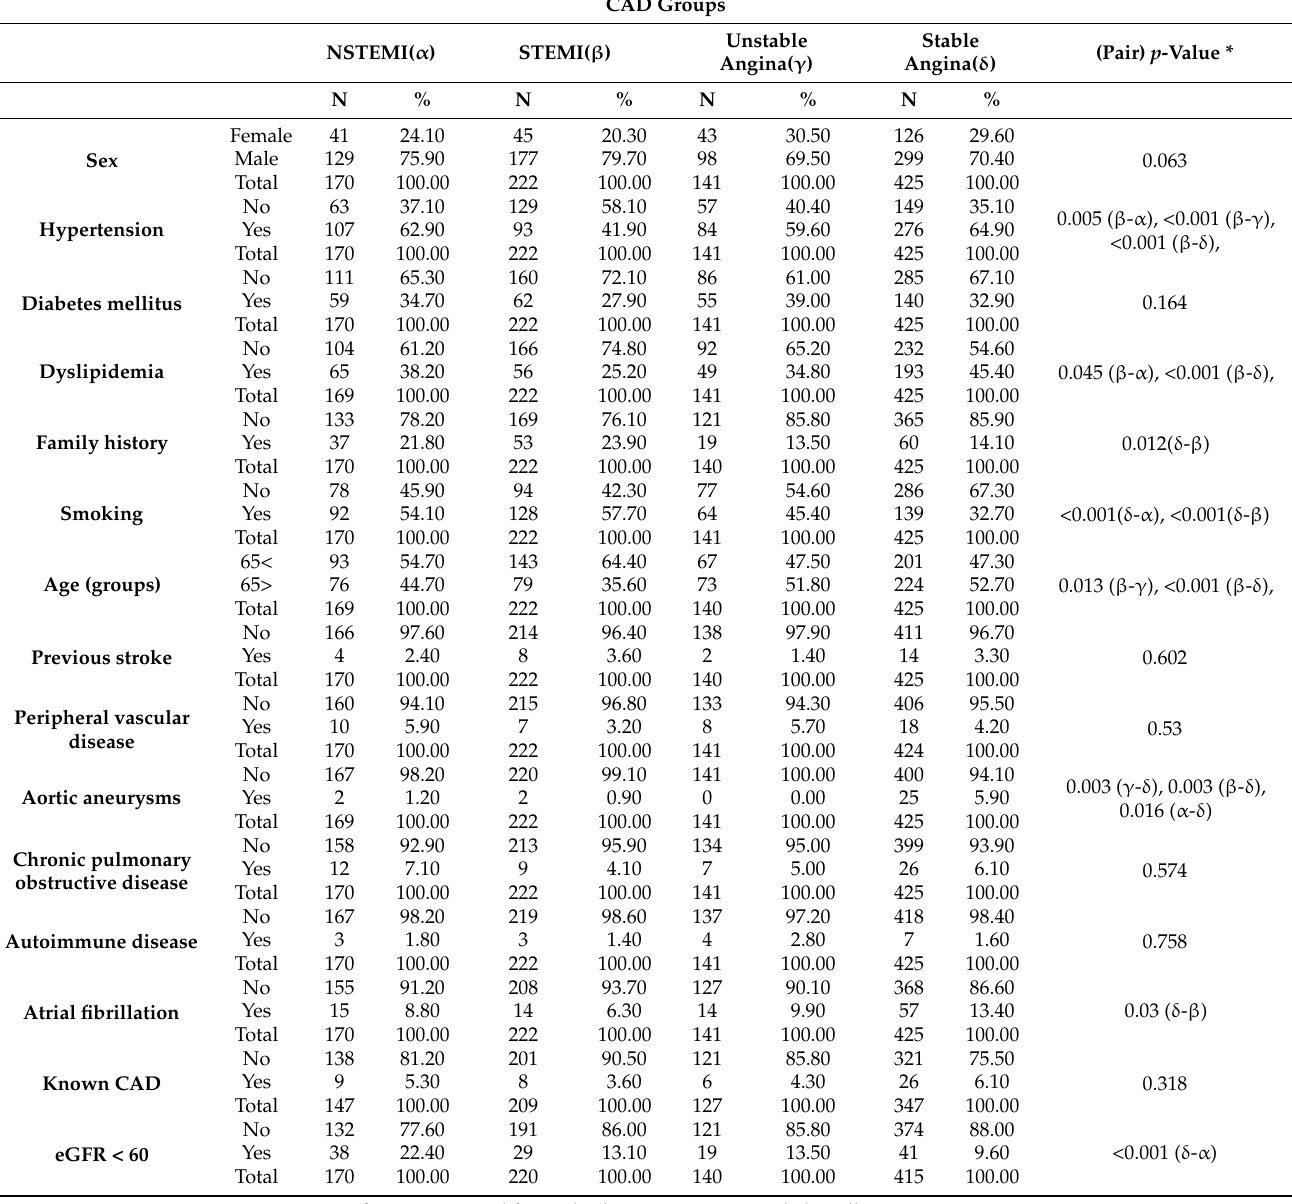
Table 3. Descriptive analyses of categorical variables per CAD